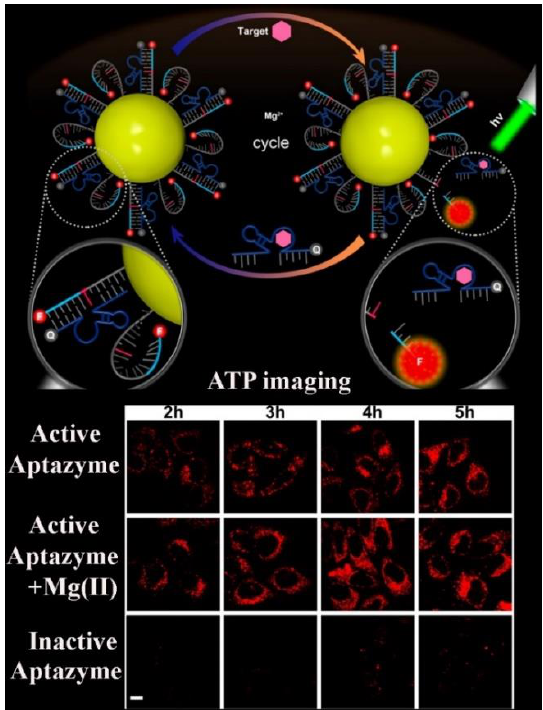
Figure 6. Representative examples for intracellular sensing and imaging of ATP based on RNA-cleaving DNAzymes. ( Top ): Working mechanism of the aptazyme – gold nanoparticle sensor for amplified ATP imaging in living cells. ( Bottom ): Real-time fluorescent monitoring of intracellular ATP. Reprinted with permission from reference [64]. Copyright 2016 American Chemical Society.